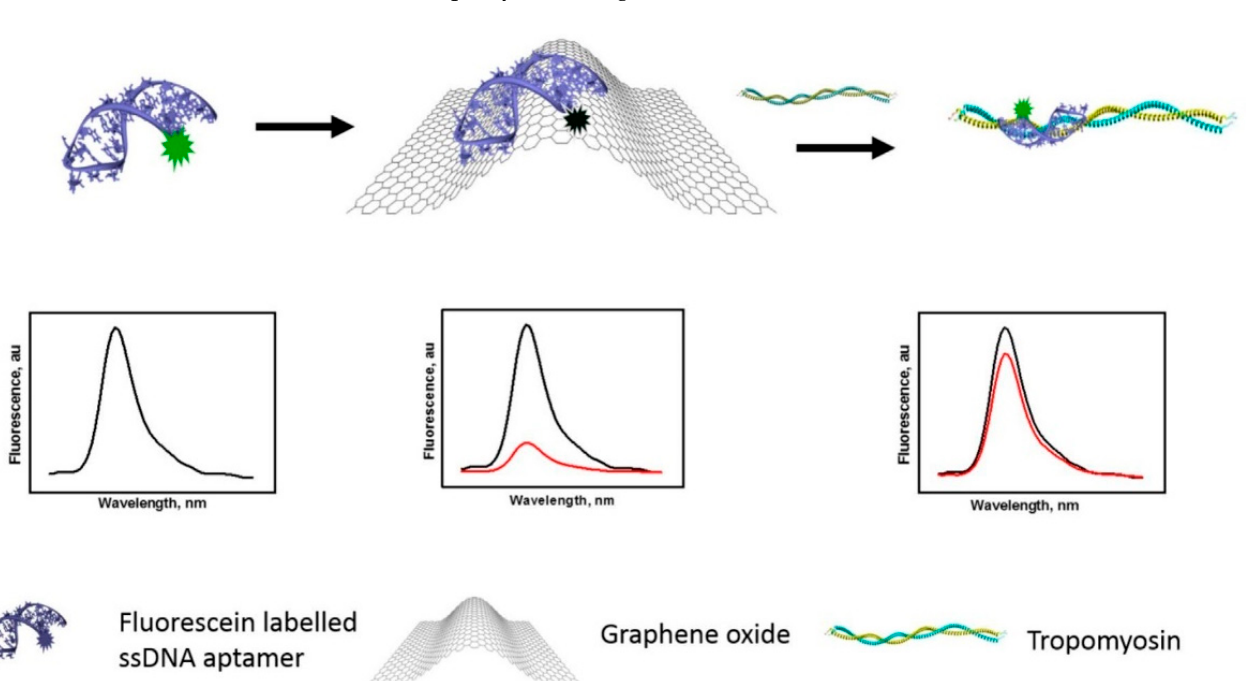
Table 3. Optical aptasensors cited in this review.